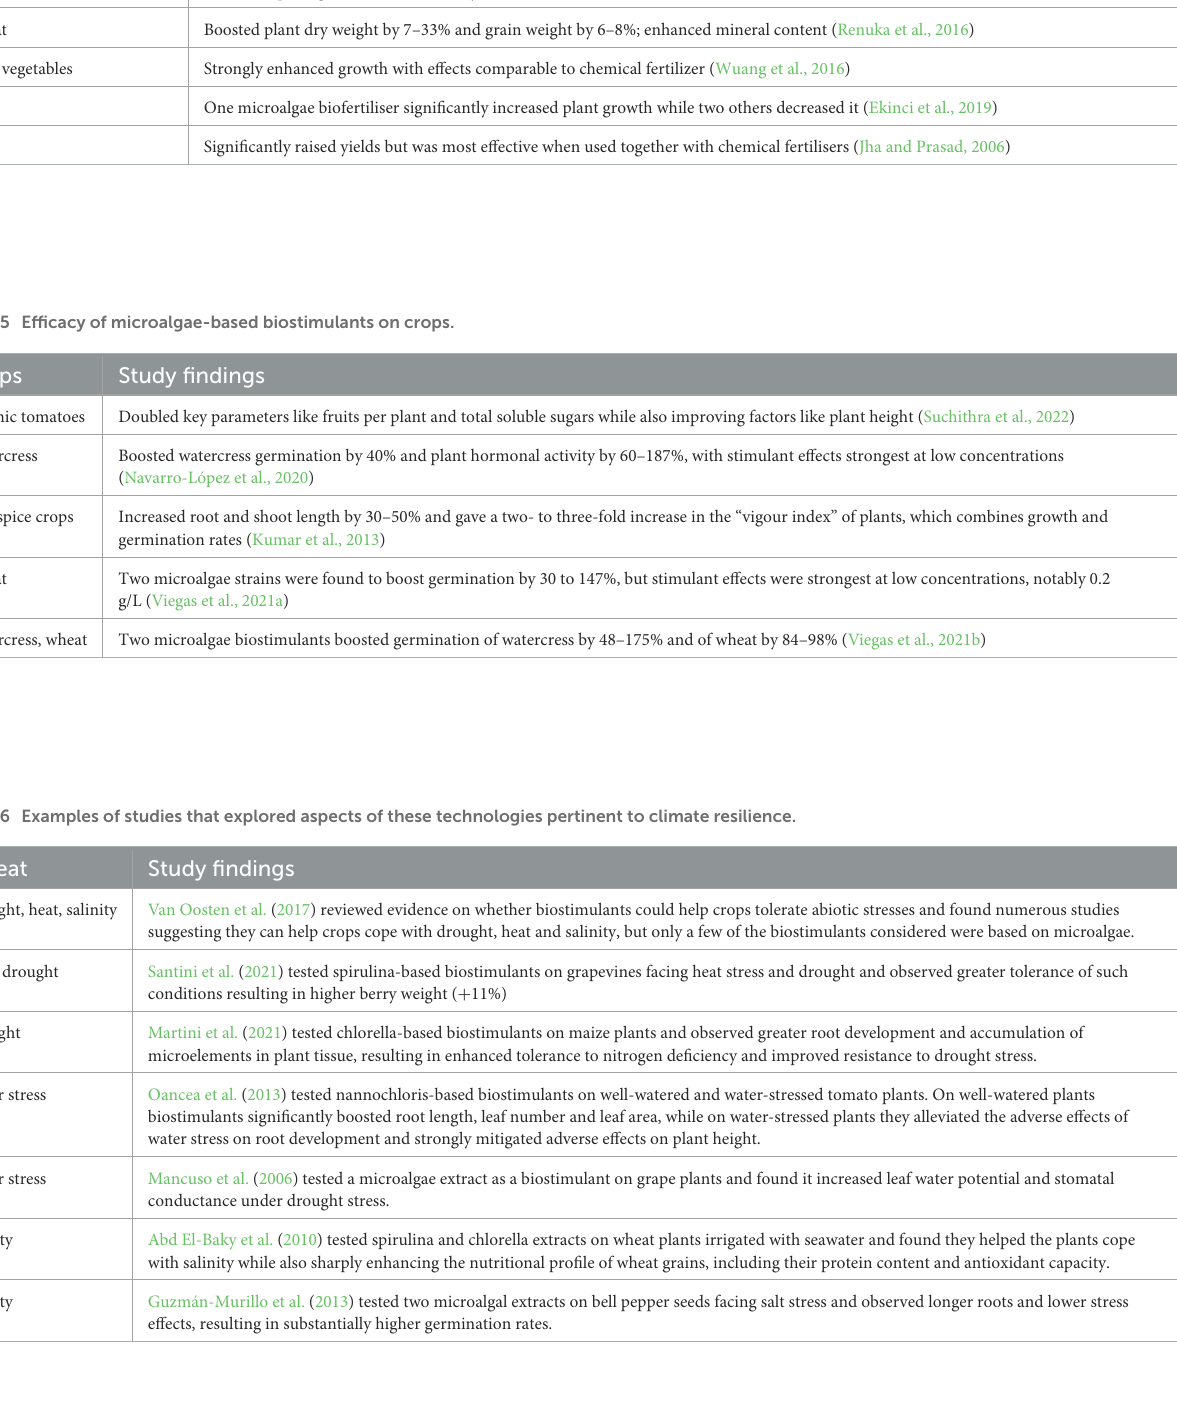
TABLE 4 Efficacy of microalgae-based biofertilizers on crops. Crops Study findings Maize, wheat